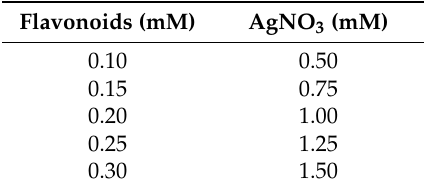
Table 1. Concentrations of flavonoids and AgNO 3